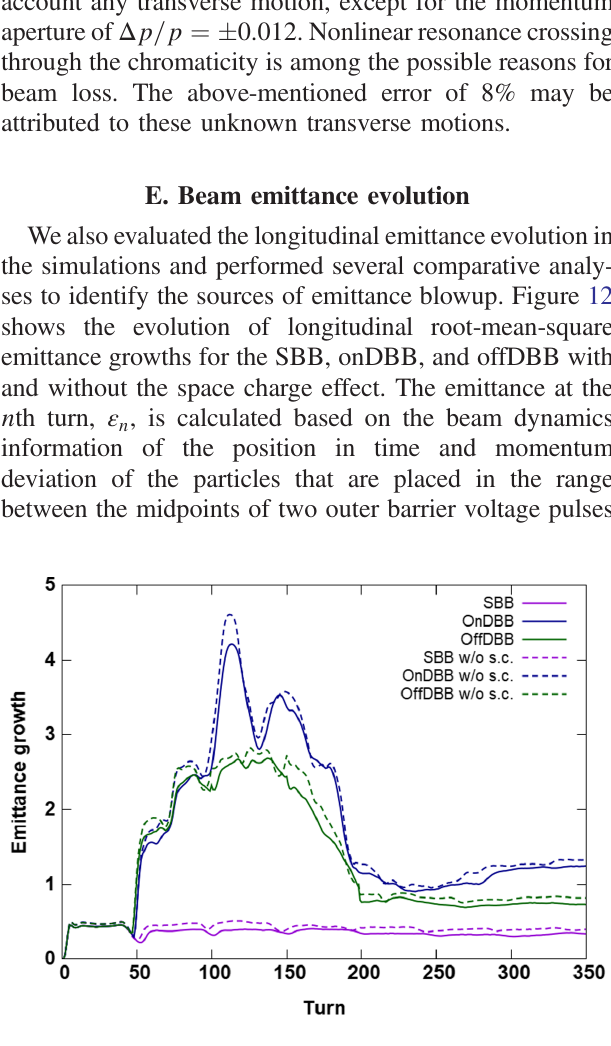
FIG. 12. Evolution of the longitudinal emittance growths in the SBB, onDBB, and offDBB with (solid lines) and without (dashed lines) the space charge